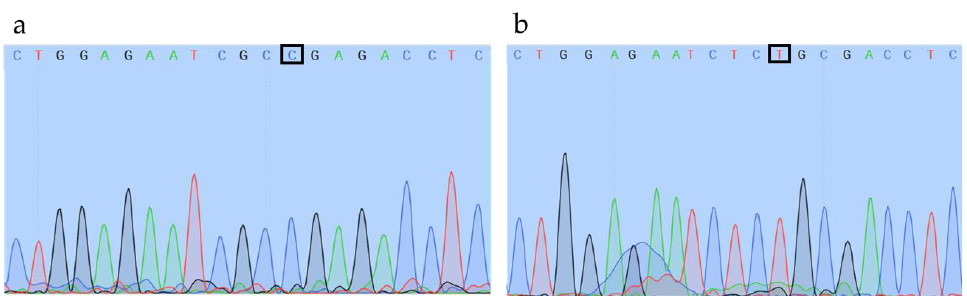
Figure 4. Sequencing results of the 253 bp and 171 bp amplicons. Gel bands corresponding to the size of 253 bp and 171 bp from three Lep+/ − mice were cut out and pooled based on their size, respectively. PCR amplicons were then purified from the gel with Zymoclean Gel DNA Recovery Kit (Zymo Research, Irvine, CA, USA), and sequenced using Applied Biosystem 3730 DNA Analyzer (Waltham, MA, USA) following an Applied Biosystems BigDye Terminator v3.1 recommendations. ( a ) sequencing result of amplicon band size of 253 bp using Reverse Outer as the primer. Cytosine in the box indicates the C allele (wildtype); ( b ) sequencing result of an amplicon band size of 171 bp using Forward Outer as the primer. Thymine in the box indicates the substitution of C to T (mutant). Table 2. Sequencing results to verify the genotypes of mice identified by the tetra-primer ARMS-PCR. Animal ID Sequencing Results Allele Genotype 129